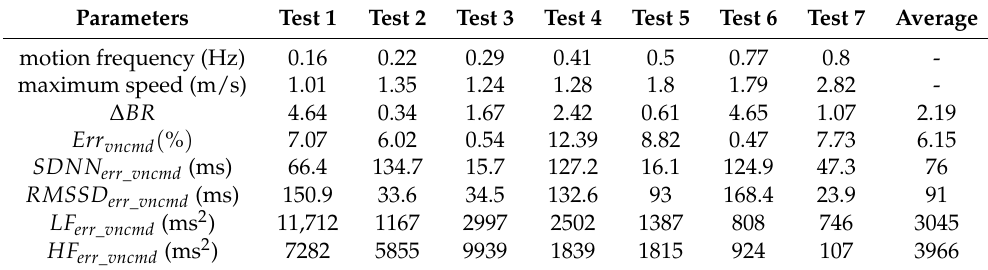
Table 6. Respiration rate and heart rate estimation and HRV analysis with different motion